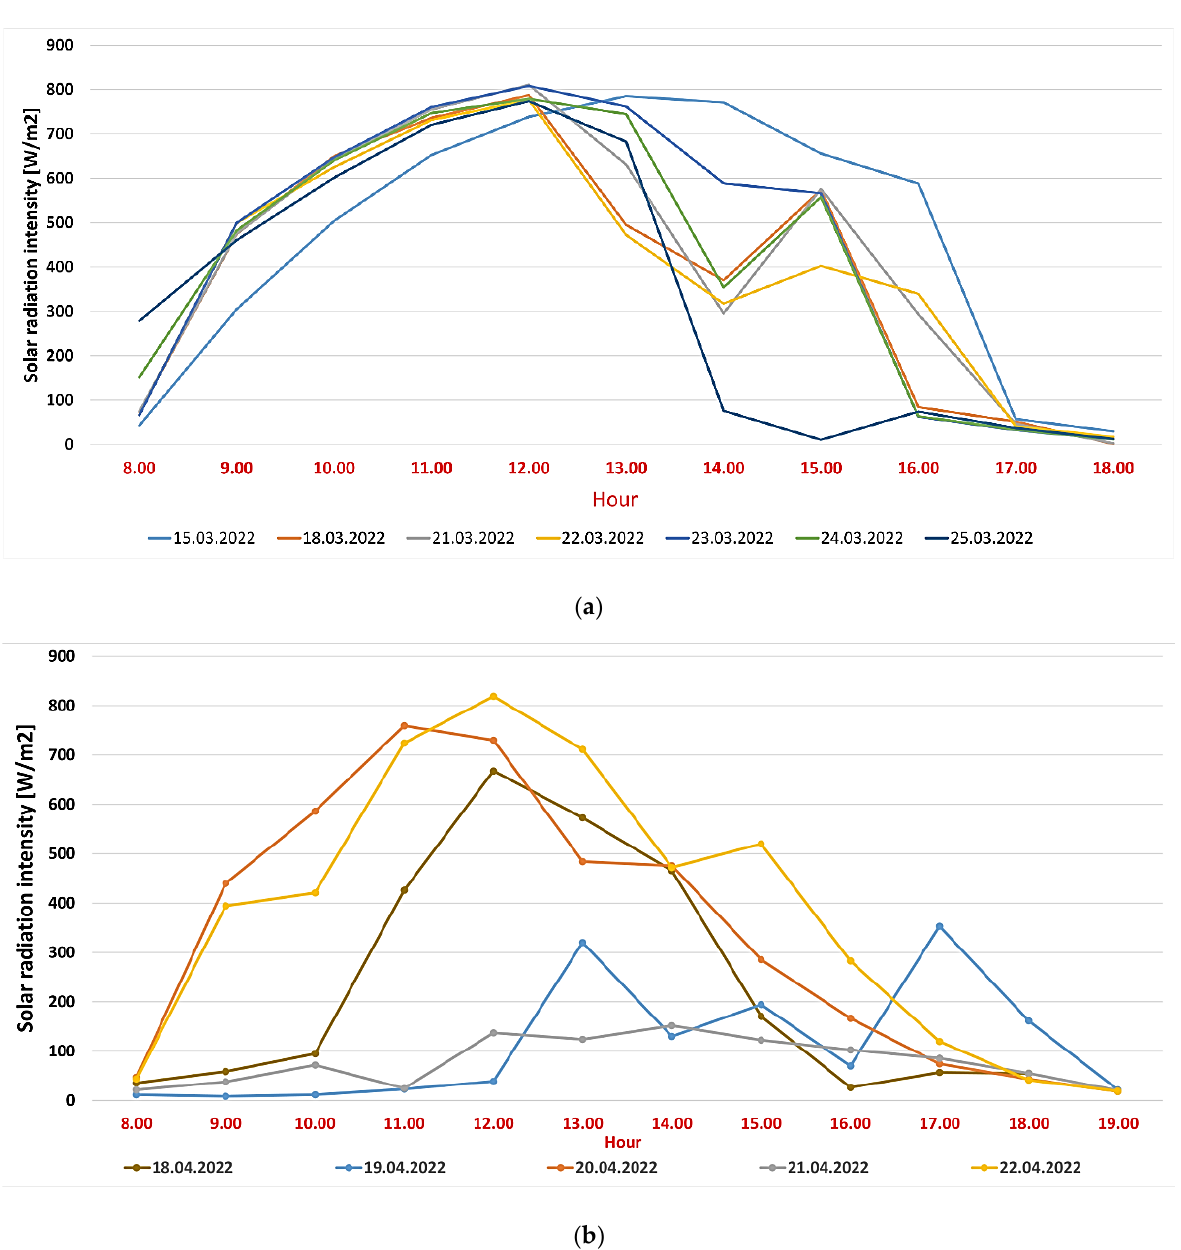
Figure 10. ( a ) Solar radiation intensity (days selected from the first-time interval). ( b ) Solar radiation intensity (days selected from the second time interval). The temperature variation inside the vending machine recorded by T1, T2, and T3 sensors is presented in Figure 11.